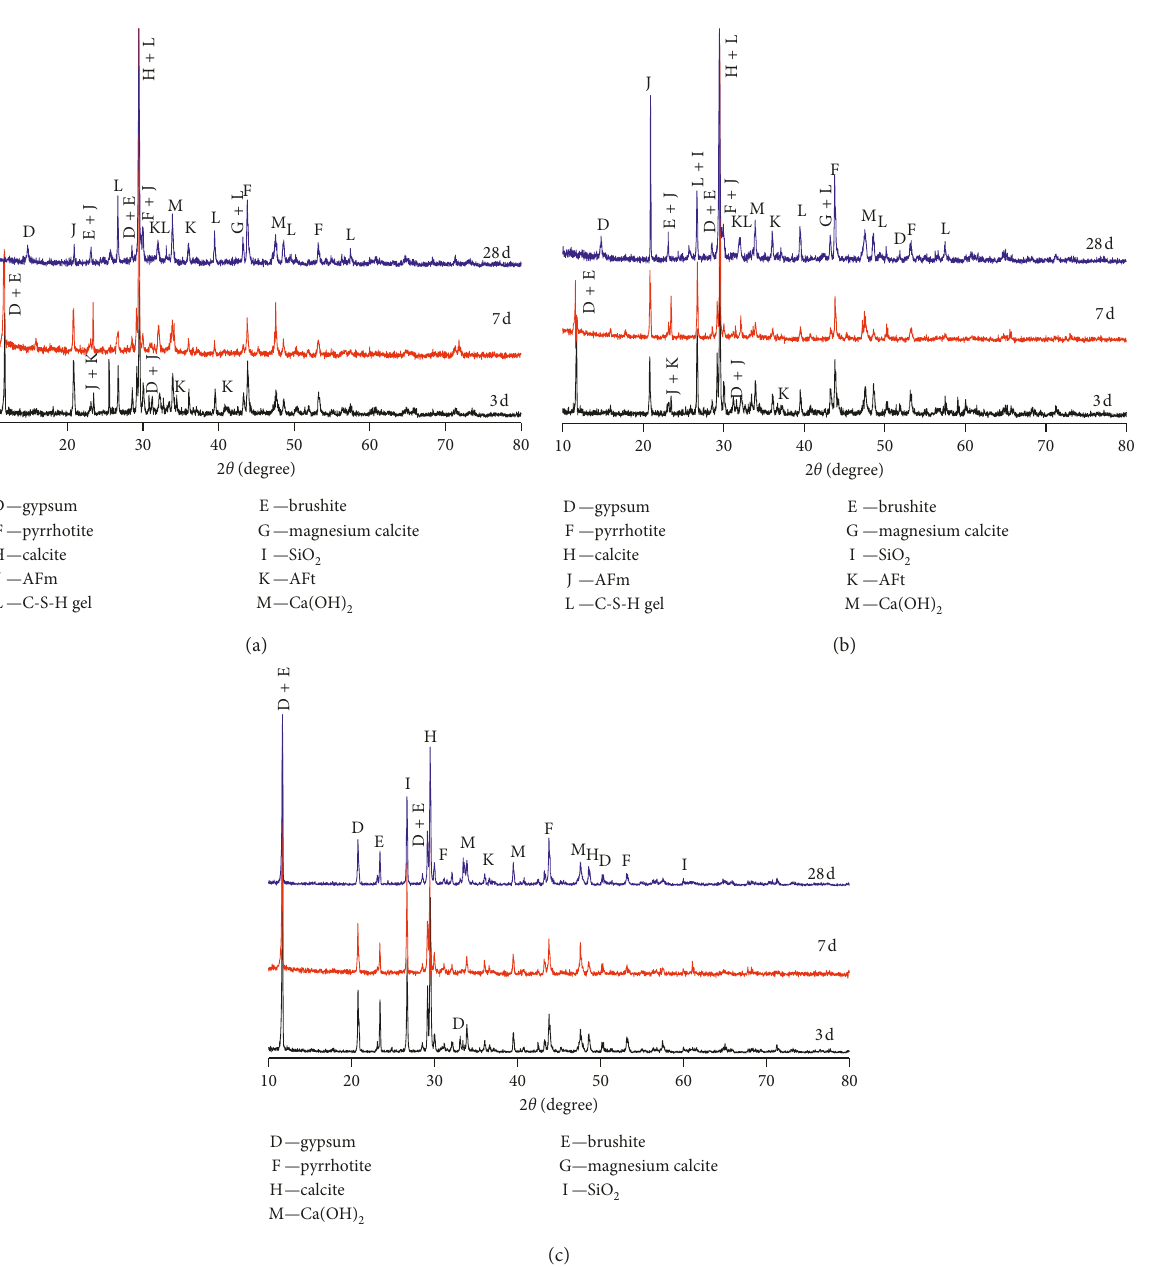
Figure 13: XRD patterns of the hydration products; (a) cement tailings backfill (CTB); (b) stone powder cement tailings backfill; (c) stone powder tailings backfill (SPTB). AFt represents ettringite; AFm represents monosulfate